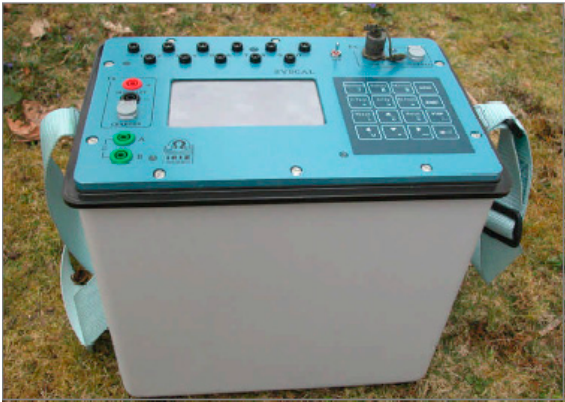
Figure A2. Syscal Pro device used when carrying out the 2D electrical resistivity tomography of this research.